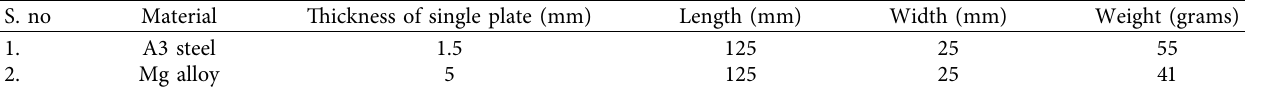
10.47 mV/g was placed at the top of the swivel plate at lo- cation points. The location points 1, 2, 3, and 4 are shown in Figure 2. The output signals are received by means of (DAQ) card 9234, which is connected to the PC and